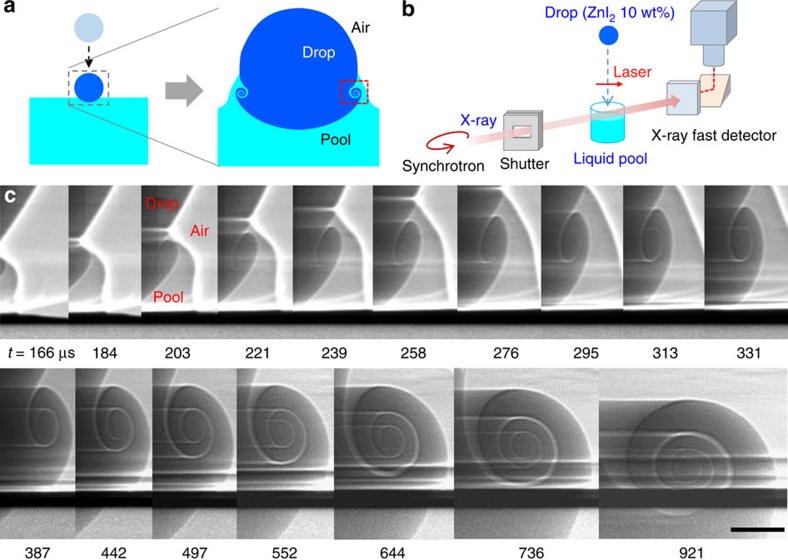
Formation of a vortex ring during drop impact.(a) Illustration of the vortex ring formation during drop impact on a pool surface. (b) Schematic of X-ray imaging coupled with the experimental set-up for the drop impact. (c) Sequential X-ray images (of the red square in a) in ethanol drop impact (with diameter ∼1.9 mm) from 80 mm height showing a positive vortical flow (Supplementary Movie 1). The interfacial boundaries between the drop fluid (dark contrast) and pool fluid are clearly resolved in a high temporal resolution. Scale bar, 100 μm long.